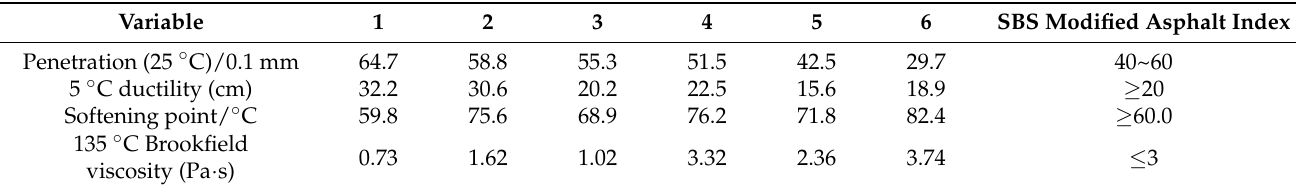
Table 8. Test results of basic physical properties of composite modified